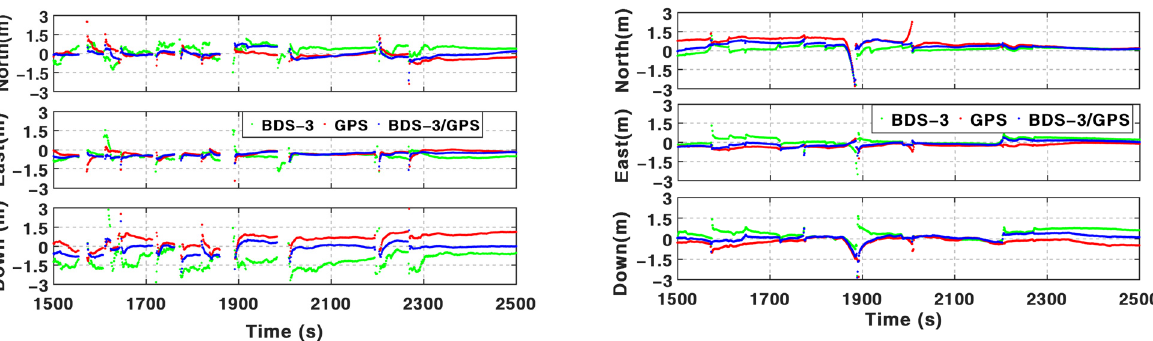
Figure 10. Positioning errors of BSSD PPP ( left ) and BSSD PPP/INS TCI ( right ) between the 1500 s and 2500 s.